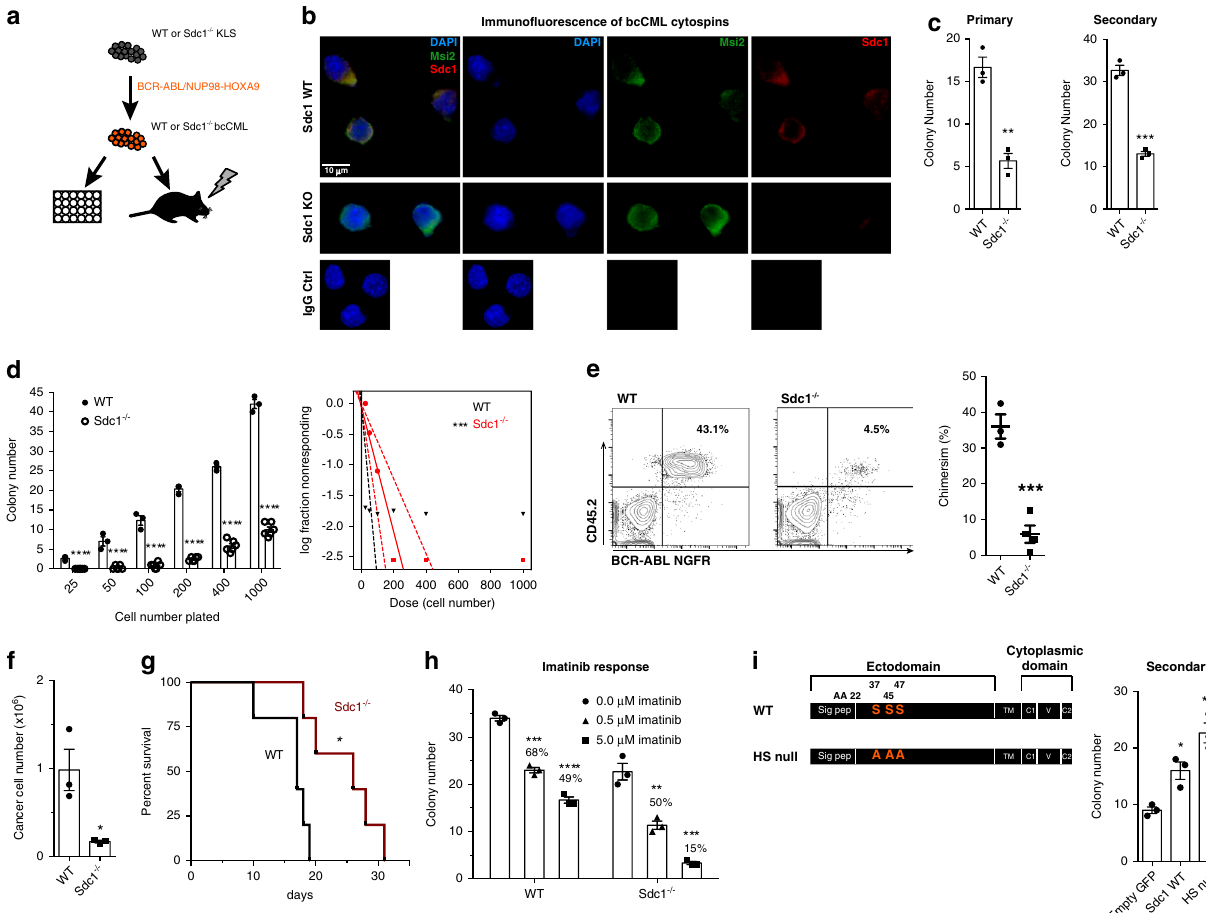
Fig. 4 Myeloid leukemia growth and propagation depend on Syndecan-1. a Approach to assess the impact of Sdc1 deletion on bcCML. b Sdc1 in WT and Sdc1 − / − bcCML (blue/DAPI, green/Msi2, red/Sdc1; 63x). c Colony formation of WT and Sdc1 − / − bcCML. ** P = 0.002 primary and *** P = 0.0001 secondary ( n = 3 technical replicates from four biological replicates). d Limiting dilution assay of WT and Sdc1 − / − bcCML (LEFT). **** P < 0.0001 ( n = 3 technical replicates from one biological replicate for WT, n = 6 technical replicates from two biological replicates for Sdc1 − / − ). Extreme limiting dilution analysis (RIGHT). Stem cell frequency: WT 1/1, Sdc1 − / − 1/94, *** P = 0.0002. e Representative chimerism in mice transplanted with WT or Sdc1 − / − bcCML. *** P = 0.0007 ( n = 3 for WT and n = 4 for Sdc1 − / − ). f Intrafemoral transplant of WT or Sdc1 − / − bcCML. * P < 0.03 ( n = 3 mice for each cohort). g Survival curves for WT or Sdc1 − / − bcCML. * P = 0.01 ( n = 5 each cohort). h Imatinib response in WT and Sdc1 − / − bcCML. Signi fi cance